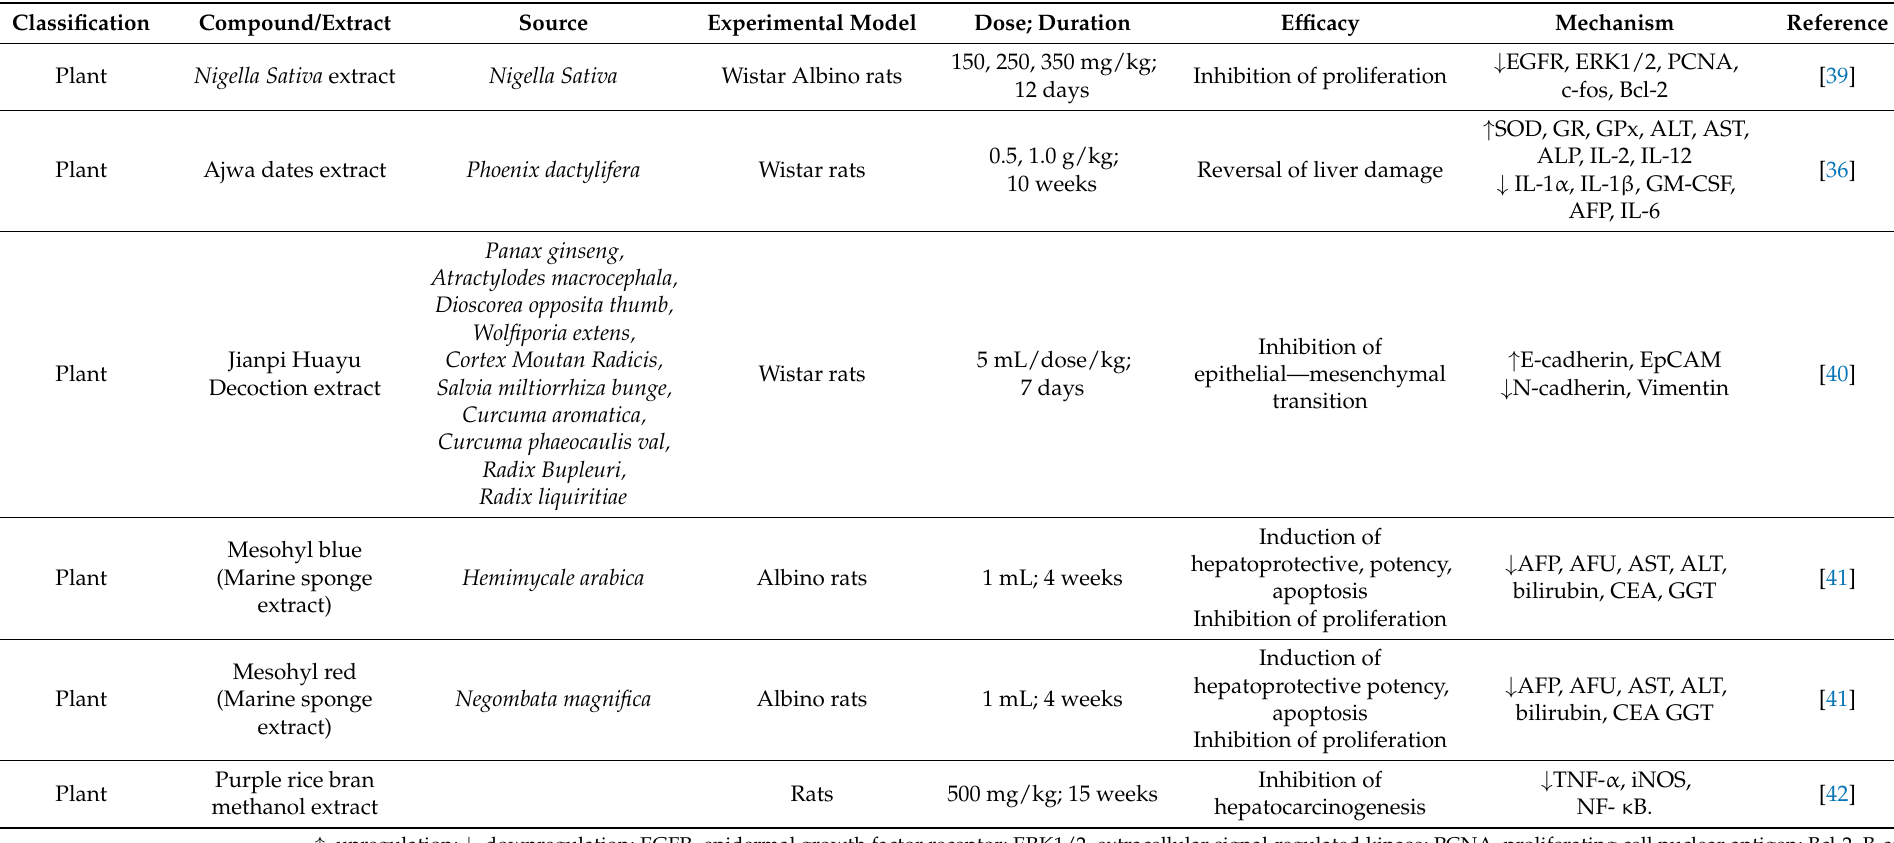
Table 3. In vivo